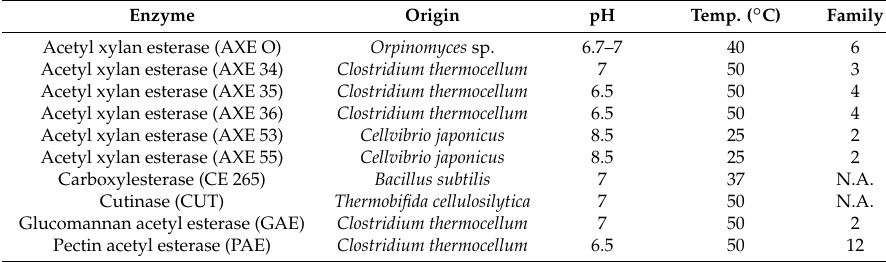
Table 3. Esterases and their optimal reaction conditions investigated for deacetylation of oligomeric model substrates and of CA. Family assignments correspond to the classification of carbohydrate esterases according to the Carbohydrate Active Enzymes database (www.cazy.org).